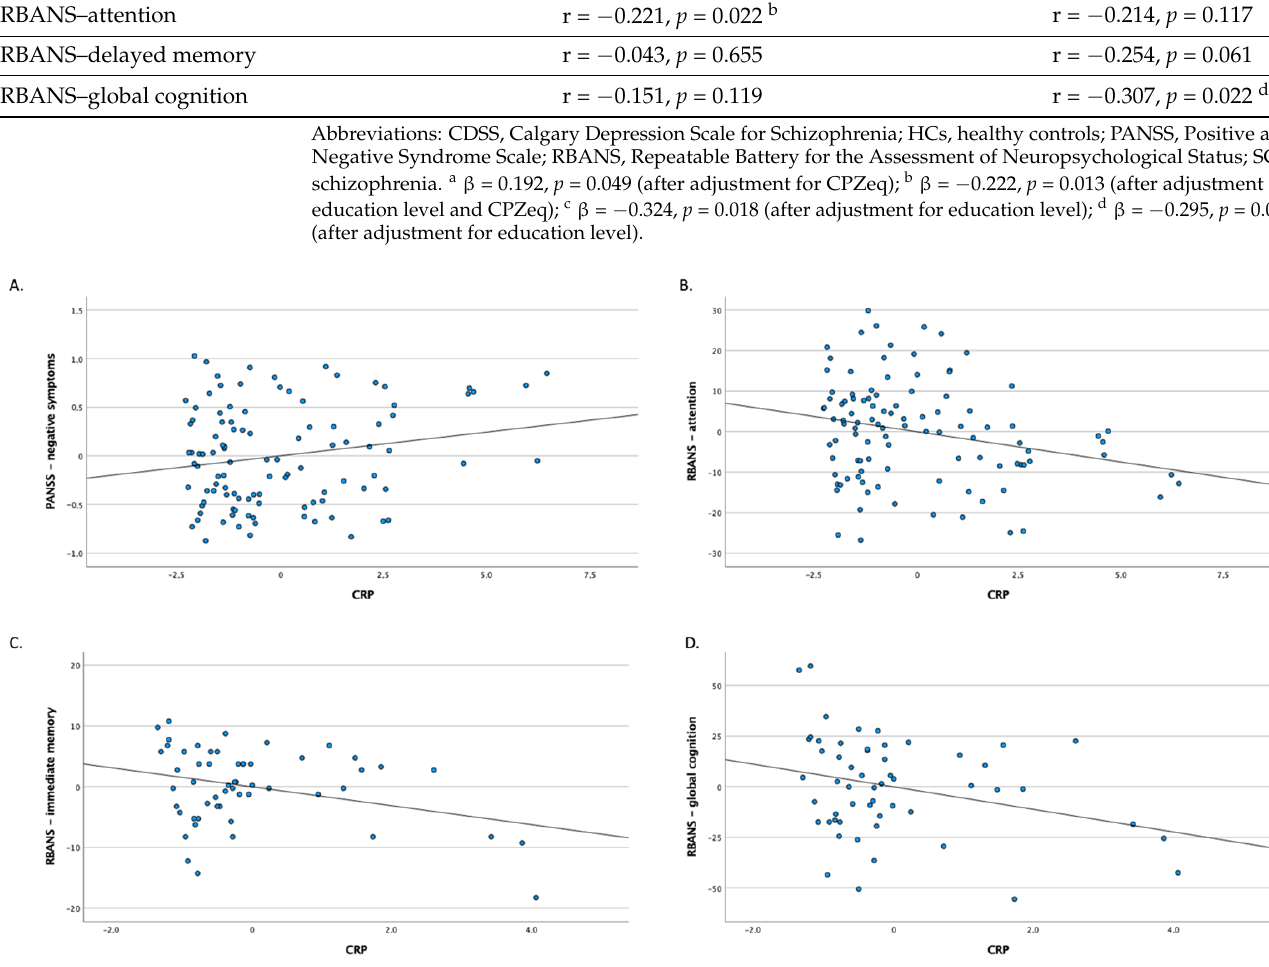
Table 4. Bivariate correlations of CRP levels with clinical manifestation and cognitive performance.